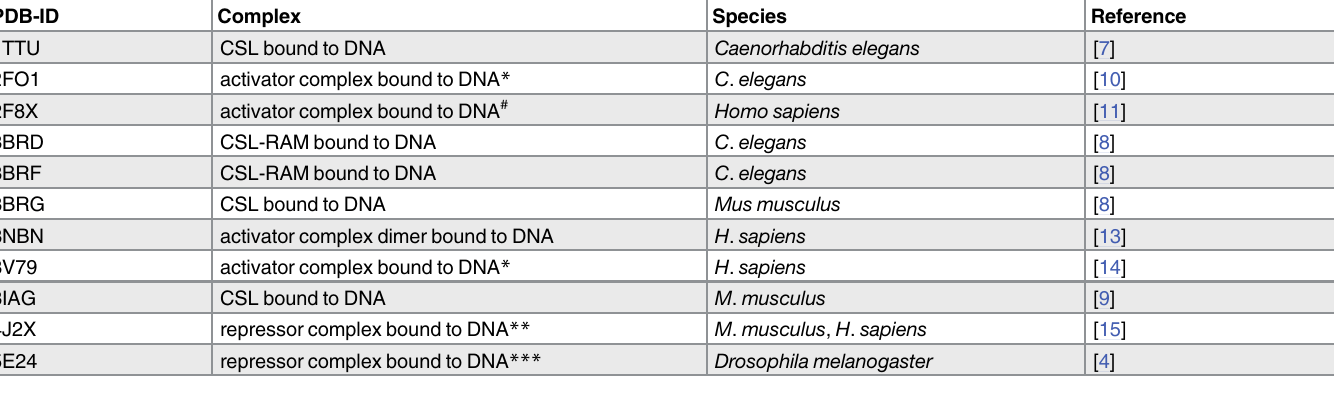
Table 1. Available CSL complex structure data (protein data bank [PDB]